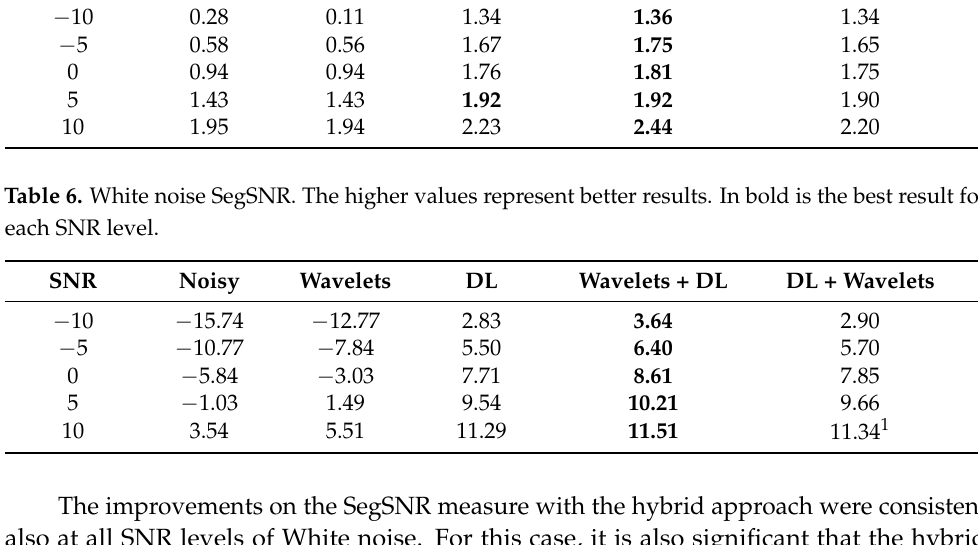
Table 5. White noise PESQ. The higher values represent better results. In bold is the best result for each SNR level. SNR Noisy Wavelets DL Wavelets + DL DL + Wavelets − 10 0.28 0.11 1.34 1.36 − 5 0.58